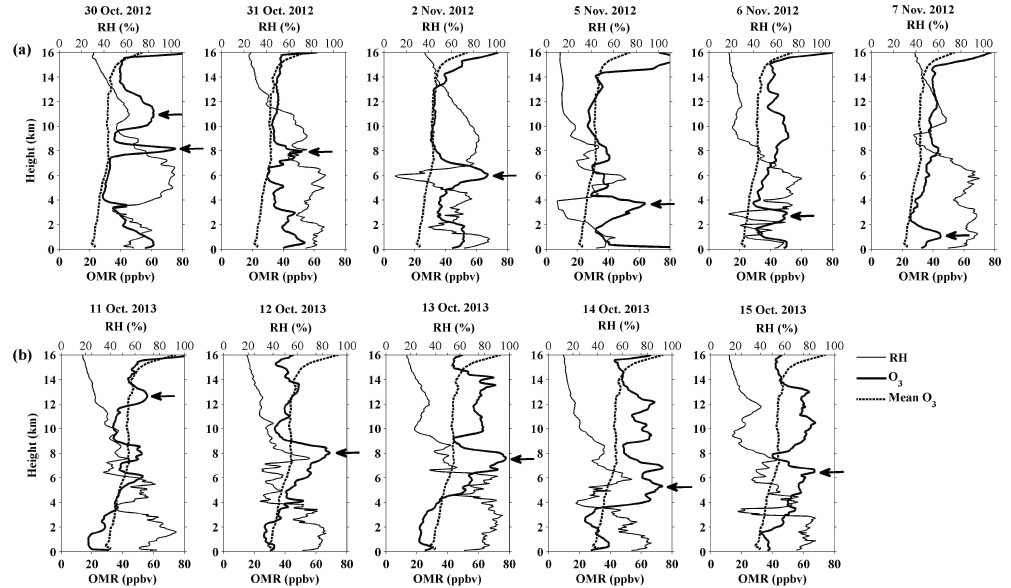
Figure 2. (a) Profiles of ozone mixing ratio (OMR) (dark black line) and relative humidity (grey line) for individual days during the passage of tropical cyclones (a) Nilam and (b) Phailin. The mean ozone mixing ratio profile for non-convective days (as control days) is shown with a dotted line. The mean profile is obtained by averaging ozone data over Trivandrum for the month of October from 1995 to 2013. Horizontal arrows indicate the height of the enhanced ozone.